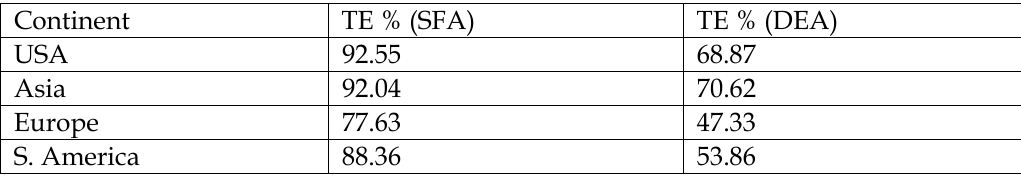
Figure 6. Average Technical Efficiency (%) by Continent of Origin Table 5. TE Estimates by Continent of Origin Continent TE % (SFA)